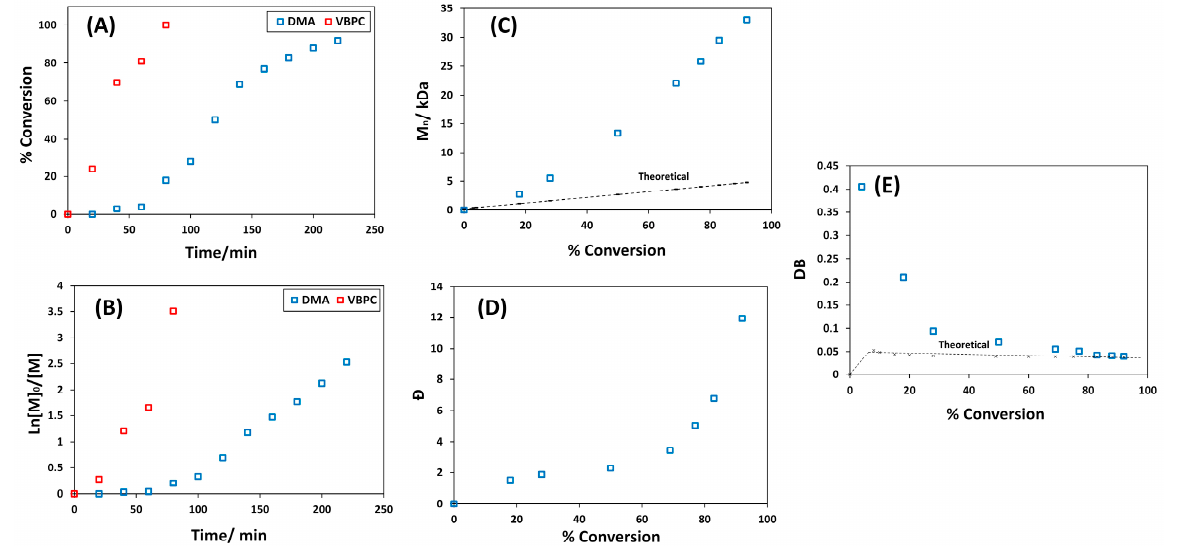
Figure 2. ( A ) Conversion vs. time plot. ( B ) Ln[M] 0 /[M] vs. time plot. ( C ) Dependence of M n on conversion in comparison with theoretical standard RAFT: M n,theo = [DMA]/[VBPC] × Mw of DMA × conversion + Mw of VBPC. ( D ) Dependence of Ð on DMA conversion. ( E ) DB vs. DMA conversion in comparison with theoretical values for RAFT copolymerization of DMA with VBPC at γ = 50 and 50 wt%.